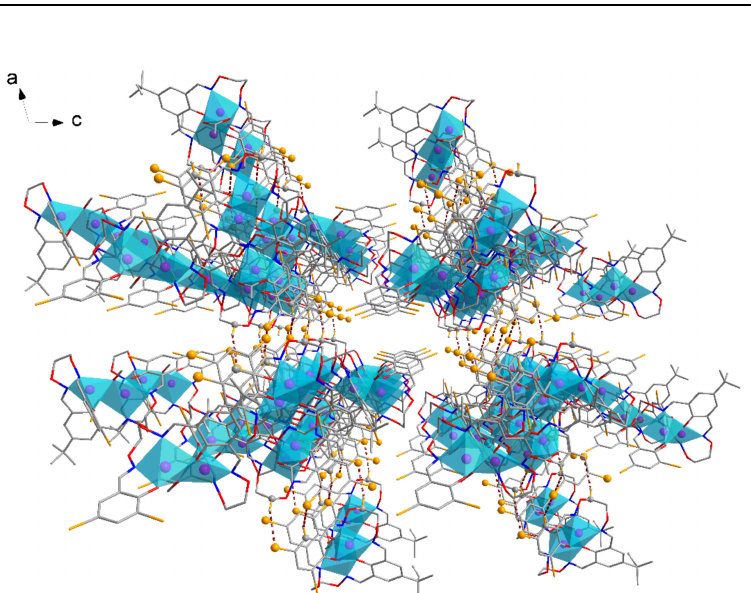
Figure 3. The 3D supramolecular structure of the coordination compound 1 with inter-molecular hydrogen bondings (hydrogen atoms, except those forming hydrogen bonds, are omitted for clarity).